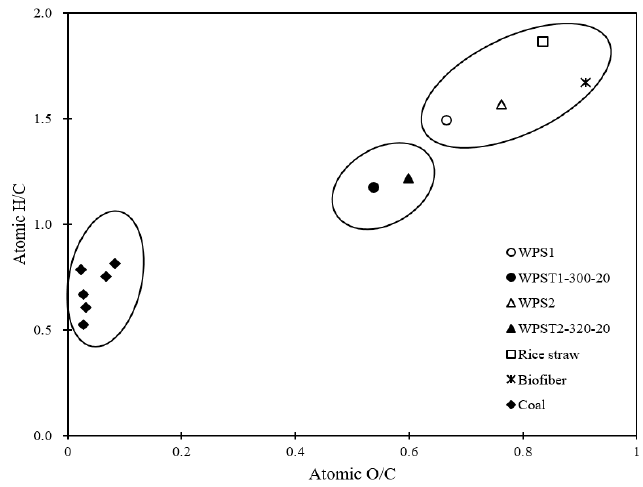
Figure 5. Van Krevelen diagram for products of this study and some carbon-containing matters. Coal: data from Kurose et al. [40]; rice straw and bio-fiber: data from Yang [35].